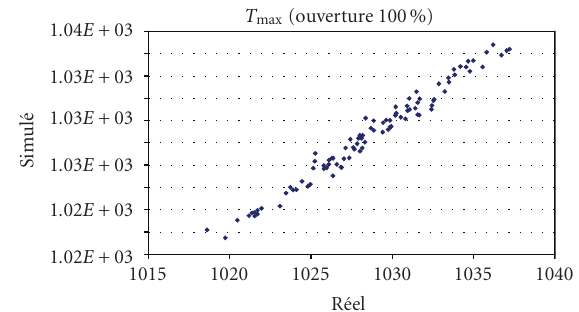
Figure 16: Real versus simulated maximum temperature in the core region.